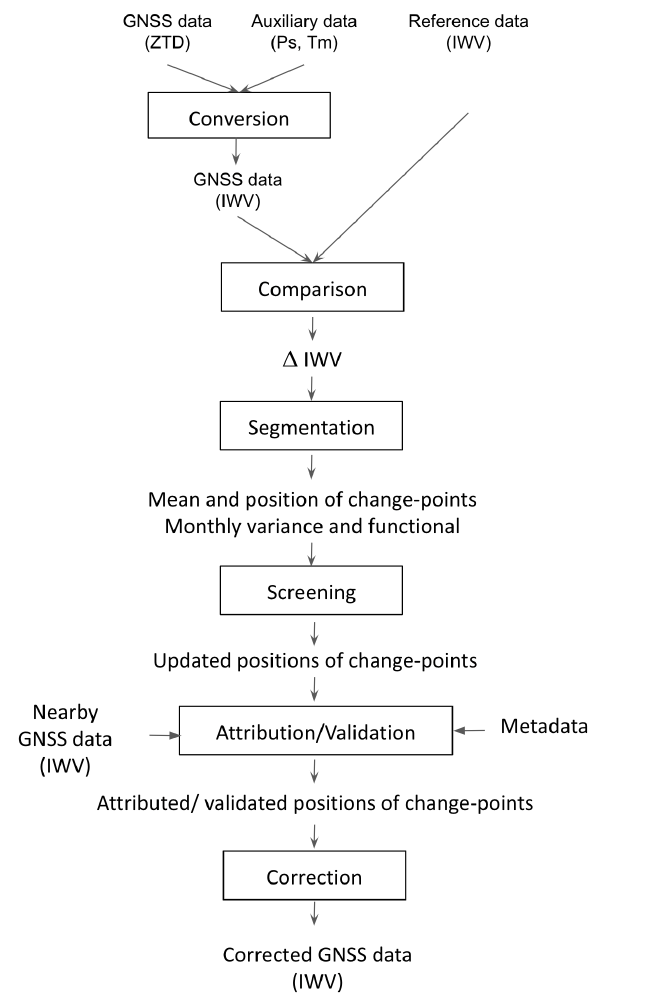
Figure 2. Flowchart of the general homogenization